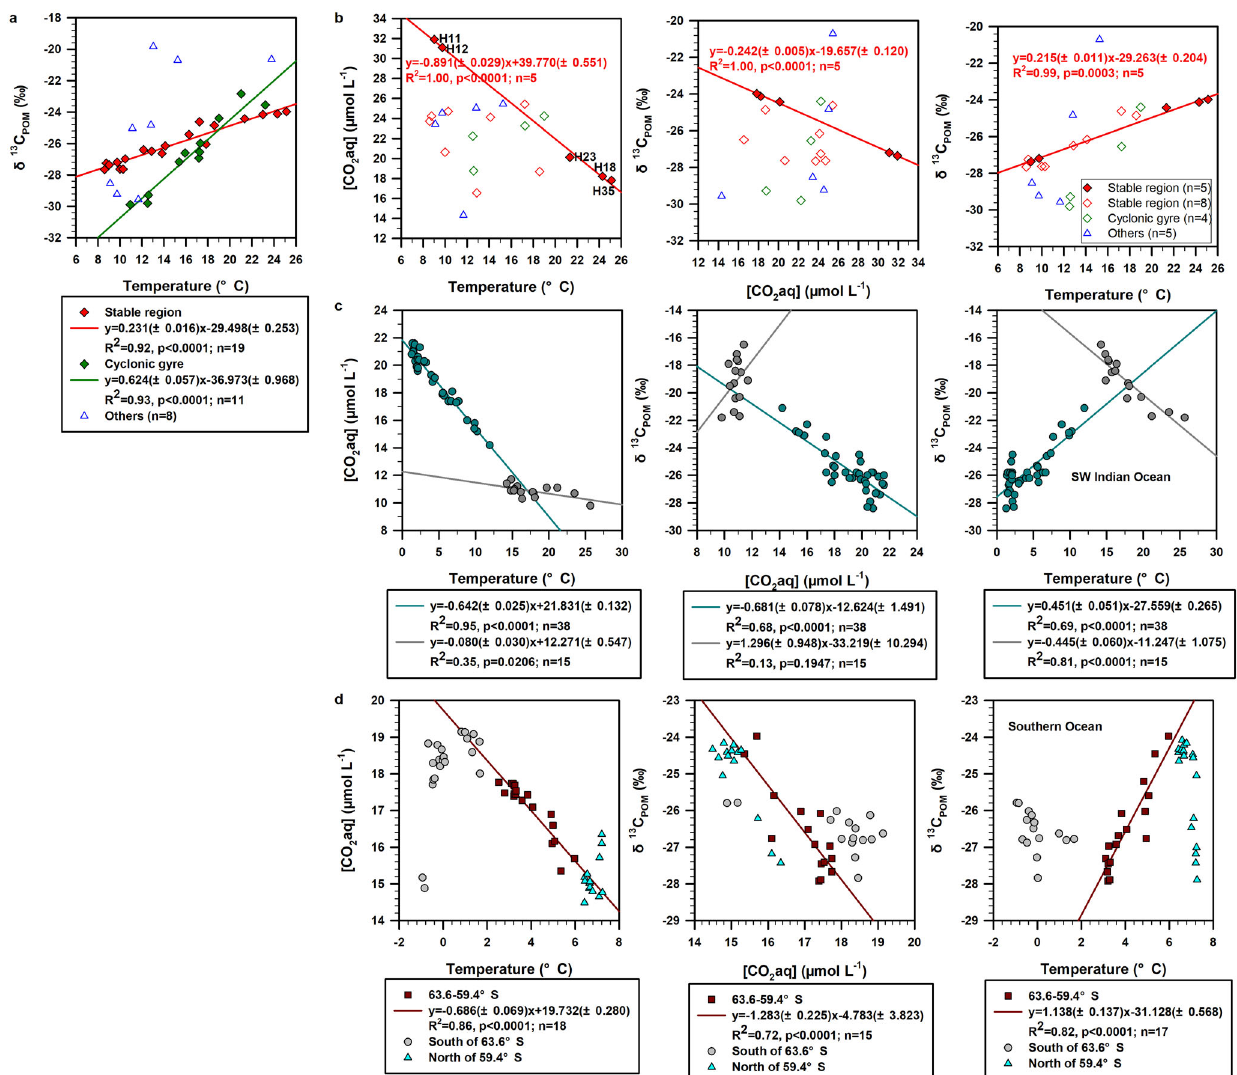
Fig. 3 Association of δ 13 C POM with temperature and [CO 2 aq]. a and b are for POM at the DCM layers of the southern Yellow Sea, and b is only for stations where concurrent measurement of [CO 2 aq] is available (red pins in Fig. 1a). c , d are same plots for compiled data of POM in the surface water of SW Indian Ocean and Southern Ocean; data in c , d are derived from Francois et al. 93 and Kennedy and Robertson 94 , respectively. [CO 2 aq] data derived from Kennedy and Robertson 21 were converted from μ mol kg ‒ 1 to μ mol L ‒ 1 by multiplying 0.001×density (kg m ‒ 3 ). The apparent trend of δ 13 C POM with [CO 2 aq] in b may not re fl ect the availability of more data in the temperature dataset, since [CO 2 aq] wasn ’ t concurrently determined with temperature and δ 13 C POM for each station in the DCM of SYS. However, data in the warm SW Indian Ocean (dark gray in c ) apparently show the presence of a robust linear relationship between δ 13 C POM and temperature under a nearly constant [CO 2 aq]. The numbers within parentheses of the fi tted equation represent standard